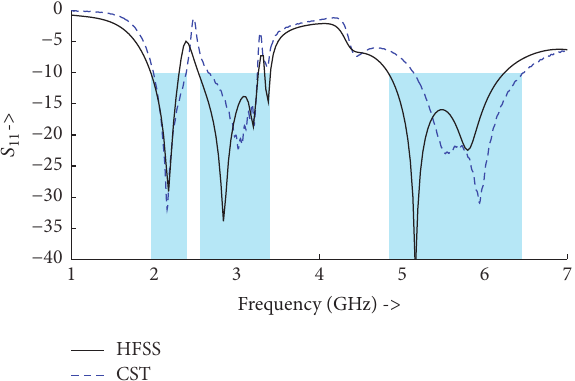
Figure 12: Reflection coefficient of the final optimized PIFA antenna.